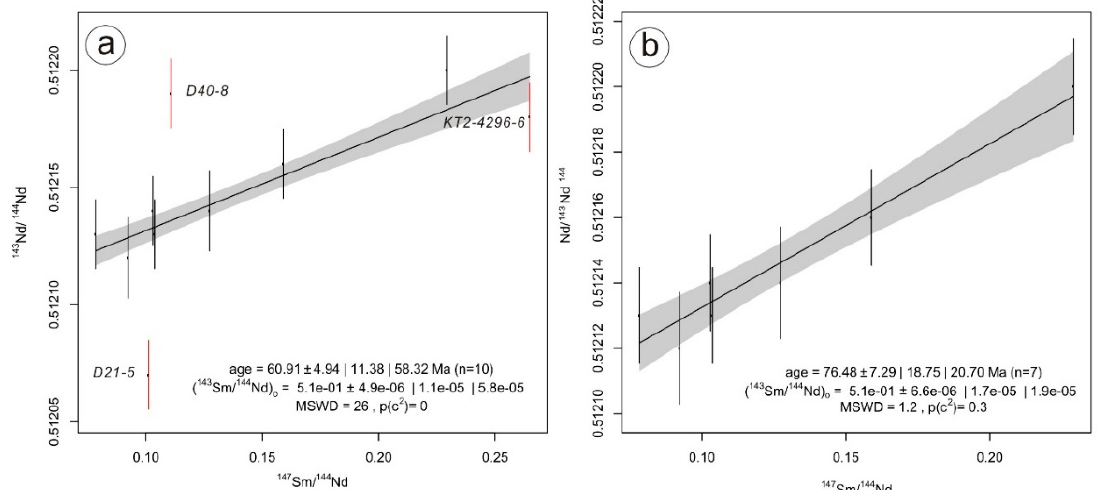
Figure 6. Sm–Nd garnet from the layered skarn ore in the Hongshan deposit. Age provided in ( a ) is calculated from all of the plotted data and age in ( b ) is calculated from seven garnet samples.